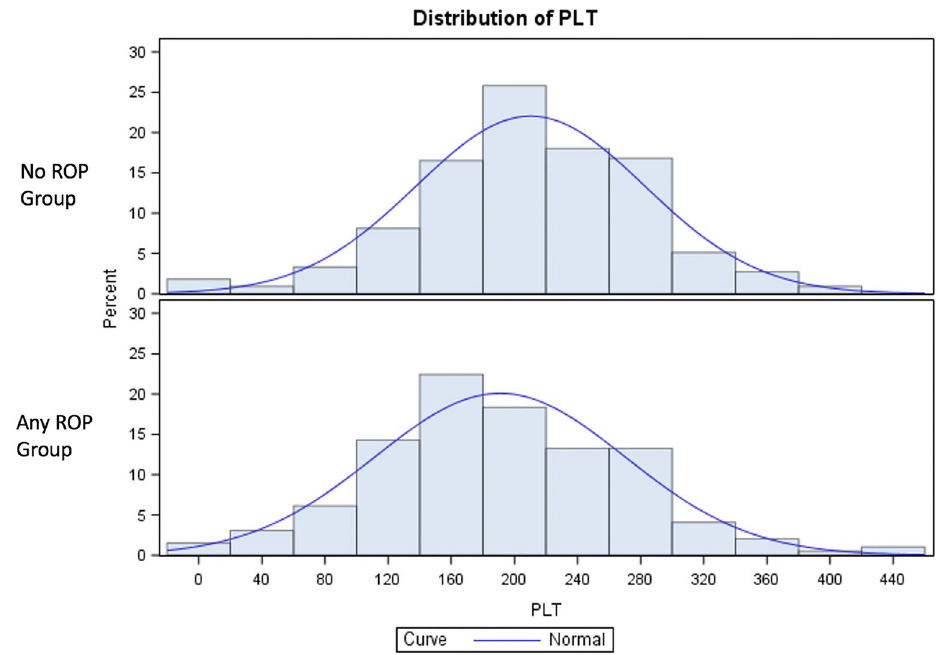
Figure 3. Distribution of platelet count (10 9 /L) in NoROP group and in infants who developed any form of ROP. ANOVA test, p = 0.0209. Platelet count was adjusted for BW and GA. PLT platelets, BW birth weight, GA gestational age.